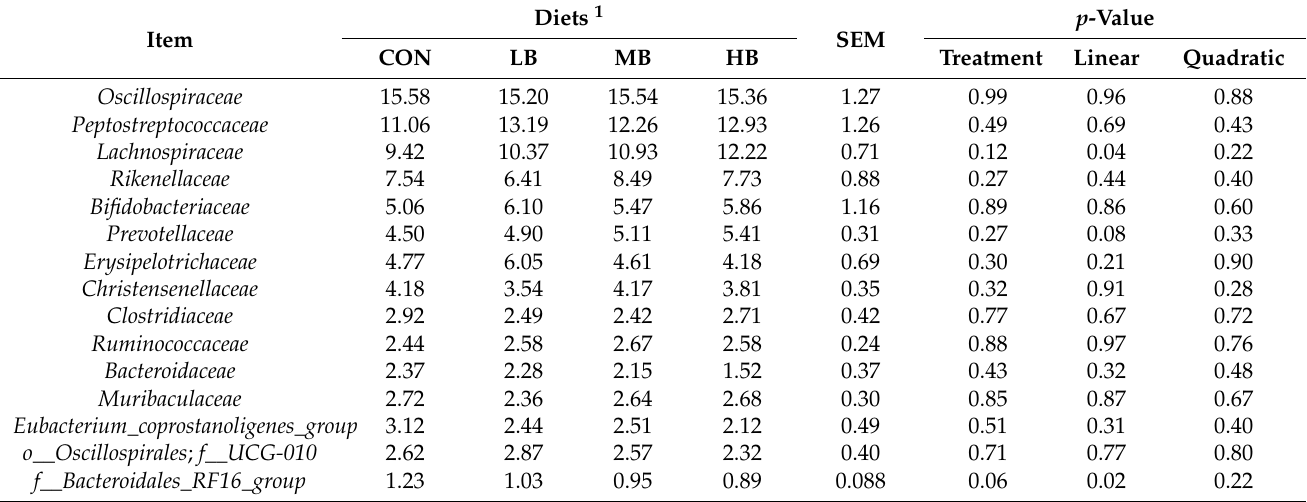
Table 4. The relative abundance of major fecal bacterial families of lactating Holstein cows fed diets with by-products substituted for forage.